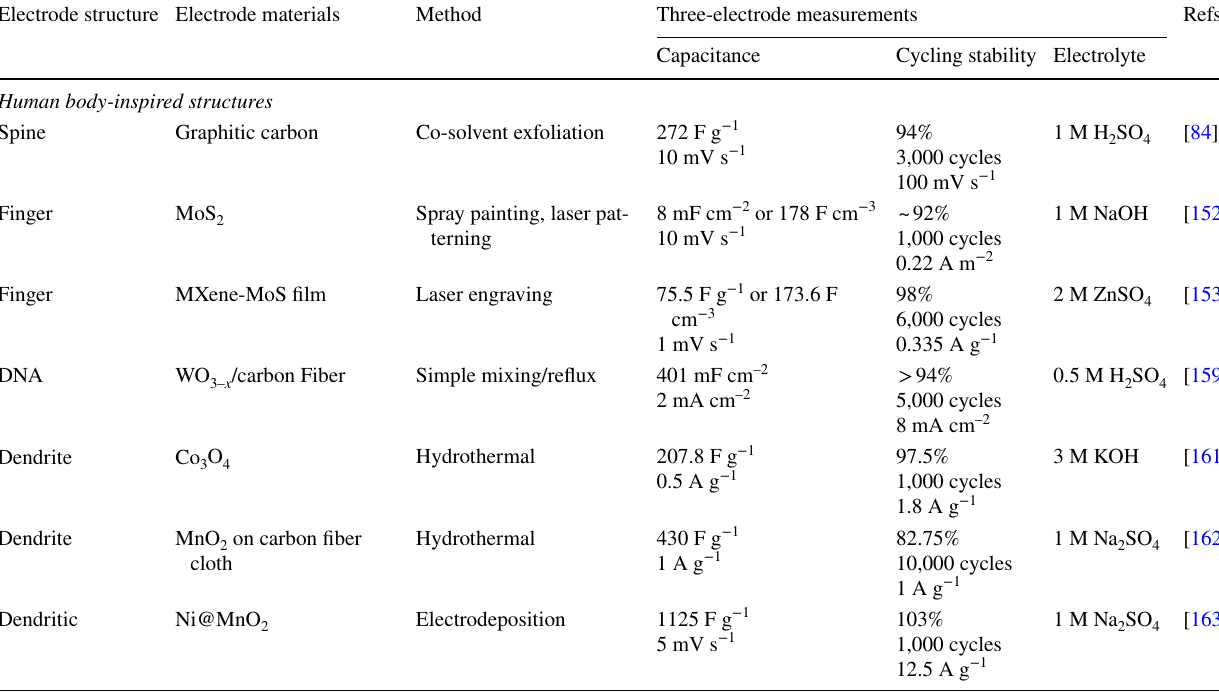
Table 3 Comparison of human-inspired structures in three-electrode measurements Electrode structure Electrode materials Method Three-electrode